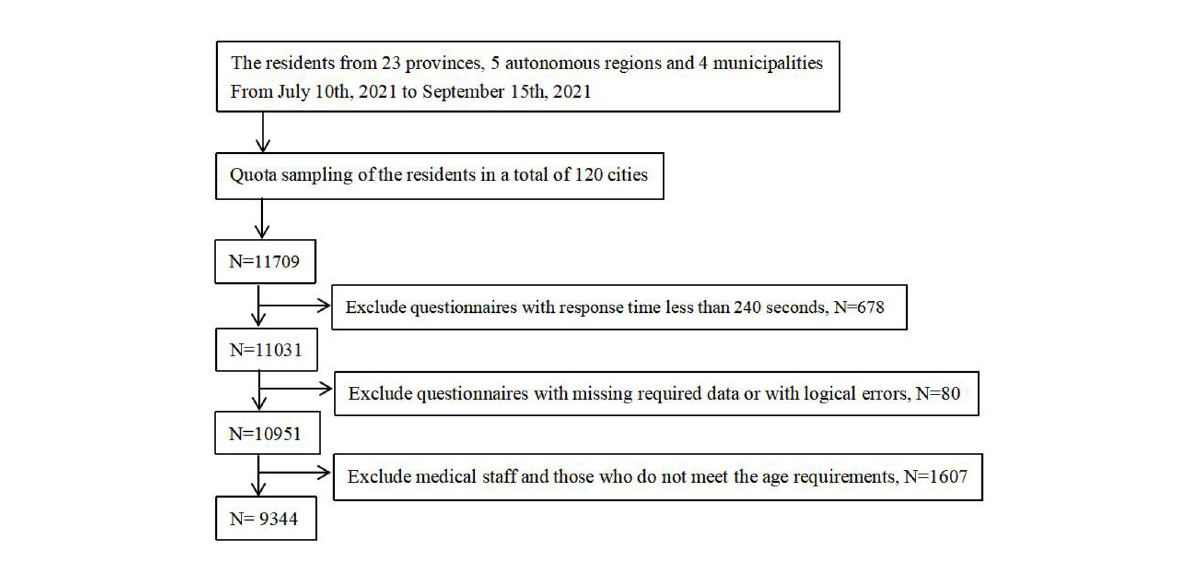
FIGURE1 Flowchart of participants’